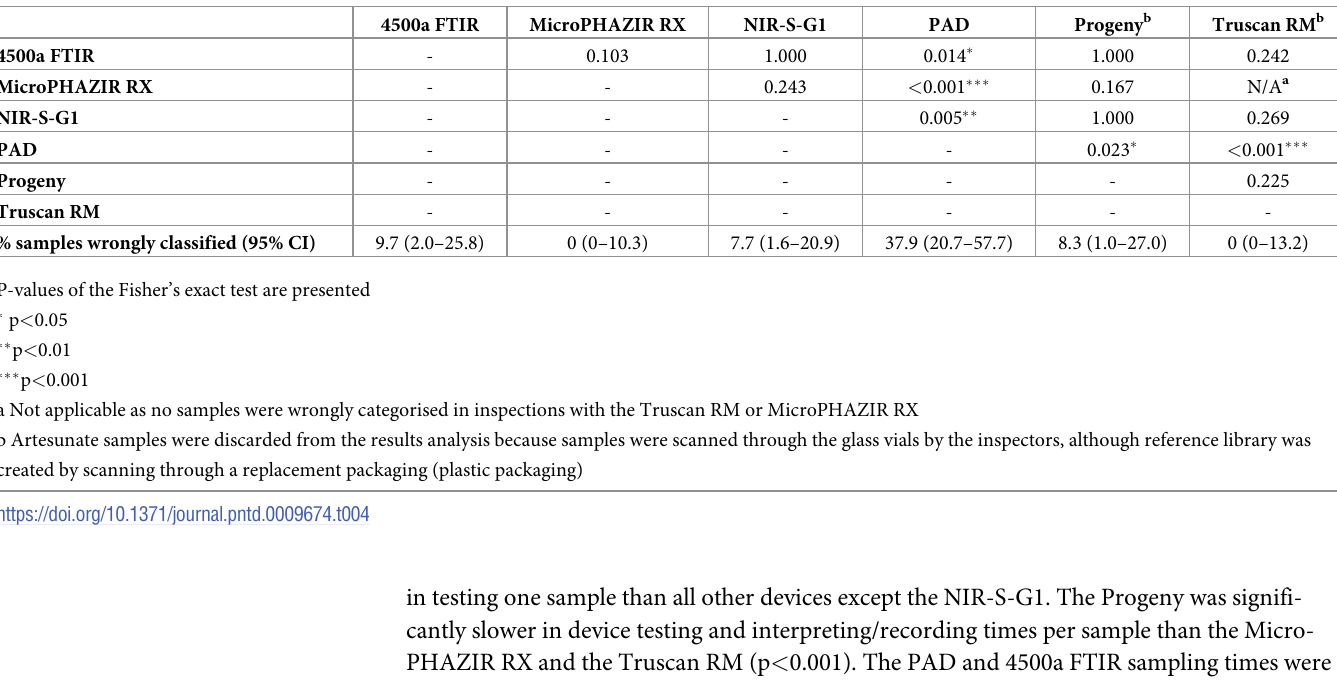
Table 4. Pairwise comparisons of the percentage of samples wrongly classified over all inspections out of total samples tested overall with the devices in the evalua- tion pharmacy